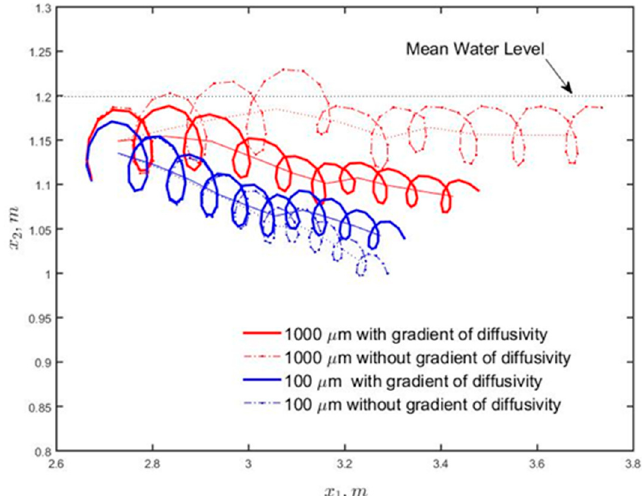
Figure 10. Ensemble averaged plume trajectory (over 500 particles of each size) of particles of diameter 100 and 1000 µ m. Release location was at x 1 ∈ [ 2.5, 3 ] m, x 2 = 1.1 m. Dotted line through the plume trajectory was obtained by window averaging over each trajectory loop corresponding to the wave period.